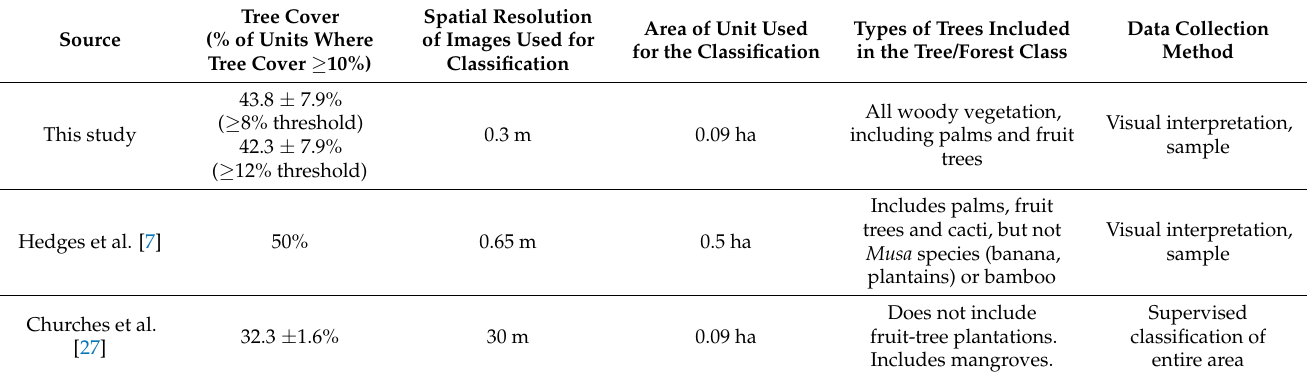
Table 4. Estimates of Haiti tree cover in 2010, derived from remote sensing